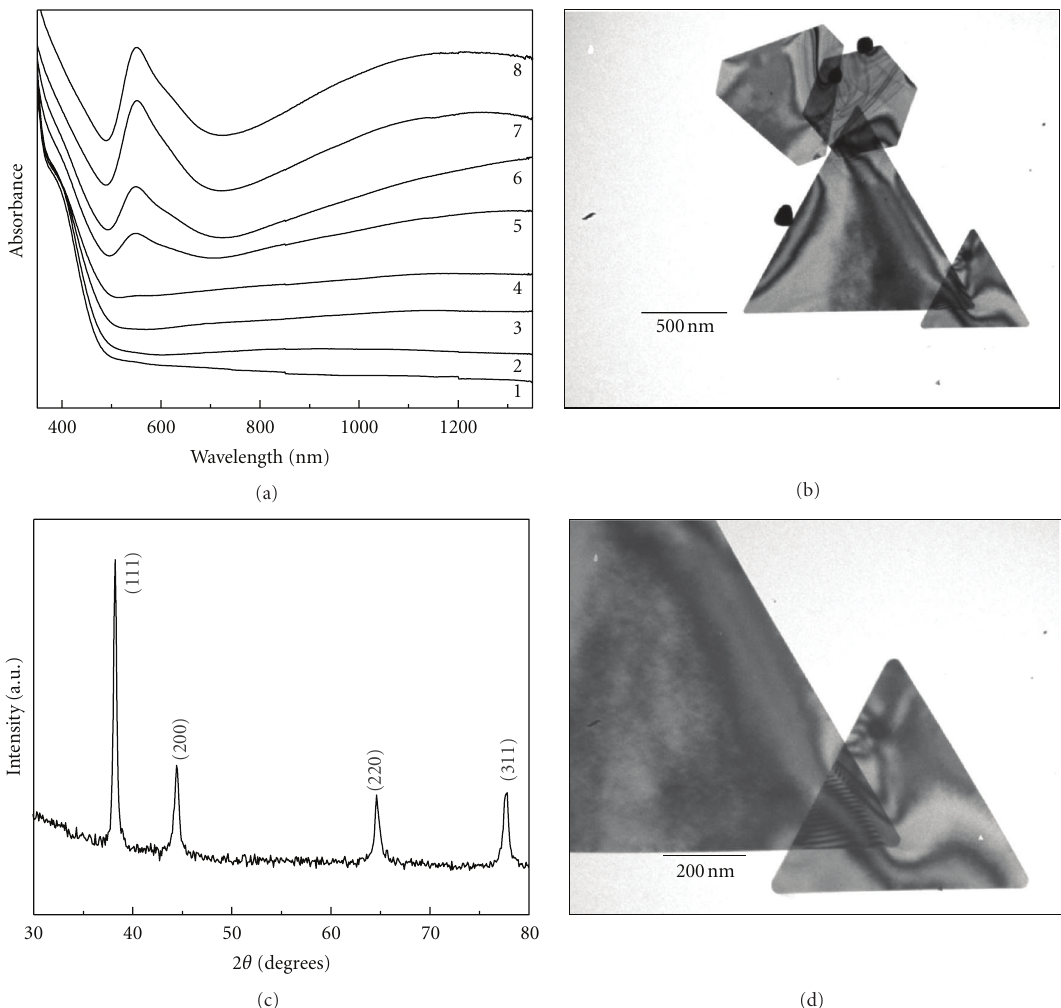
Figure 1: (a) UV-vis-NIR kinetics of the reaction of Piper betle leaf extract with aqueous chloroaurate ions. Curves 1–8 correspond to 0, 10, 60, 120, 180, 240, 480, and 720 min after reaction, respectively. (b) Representative TEM micrographs of triangular gold nanoparticles obtained by the reduction of AuCl 4 − by Piper betle leaf extract. (c) XRD pattern of Piper betel leaf extract reduced nanotriangles with identified Bragg reflections. (d) A high magnified TEM micrograph of the single gold